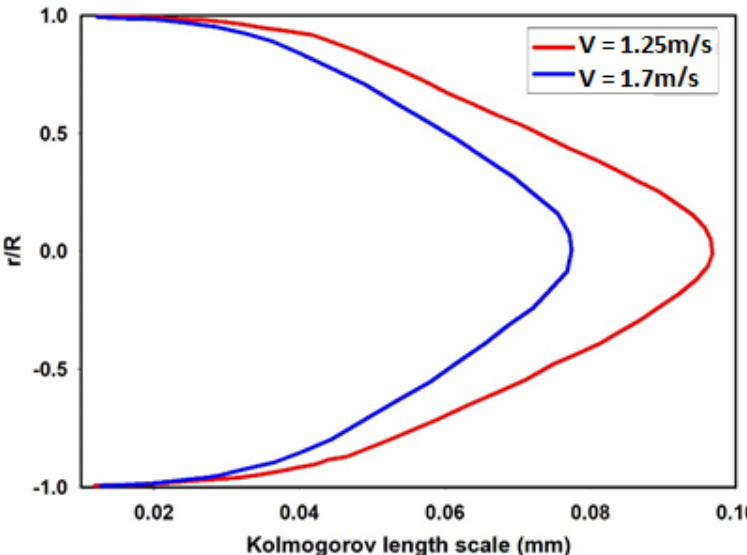
Figure 3. Contours of Sauter mean diameter (m) as obtained by CFD model ( a ) test 1 (V = 1.25 m/s, water cut = 0.05), ( b ) test 2 (V = 1.7 m/s, water cut = 0.05).